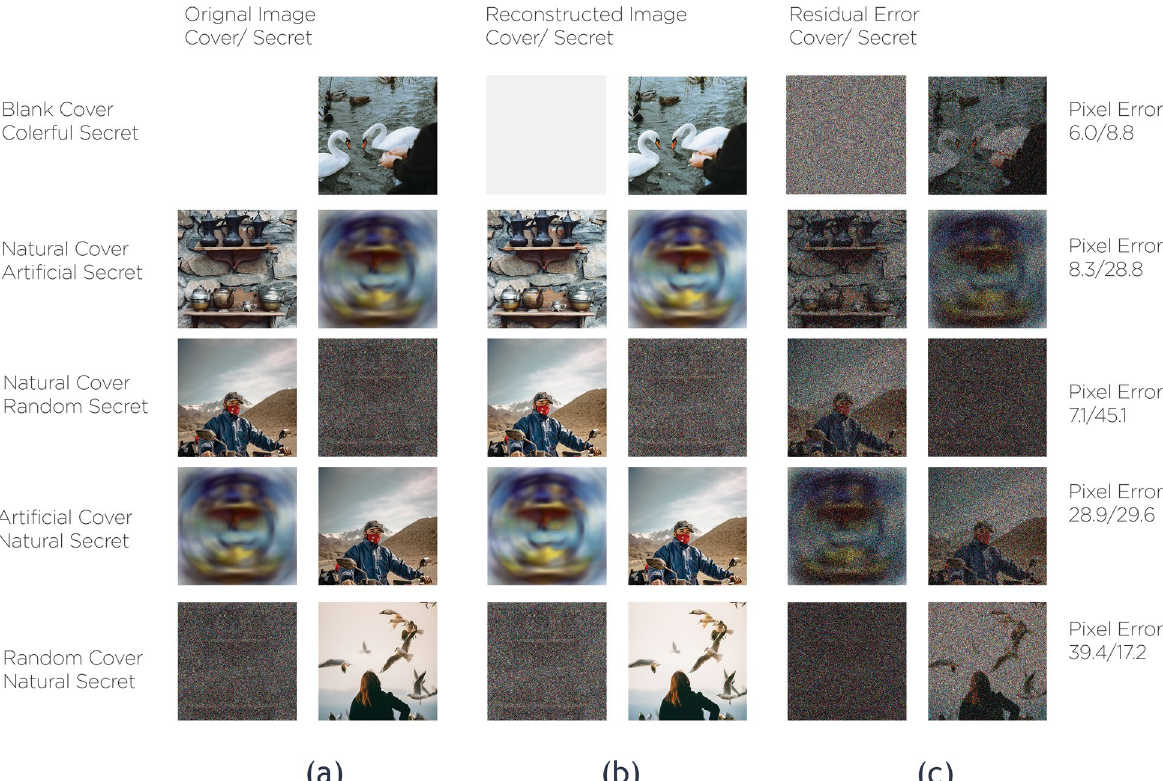
Fig. 16 The images result in three doubled rows for ‘Cover Image’ and ‘Secret Image’ in three conditions: a Original Images, b Reconstructed Images, and c Residual Error, along with the pixel error rate on the right